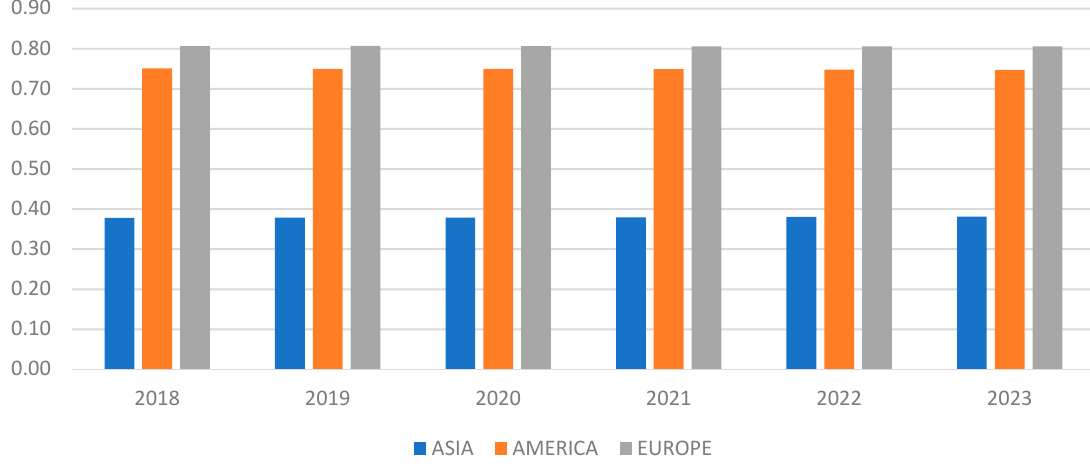
Figure 6. E ffi ciency score from 2018 to